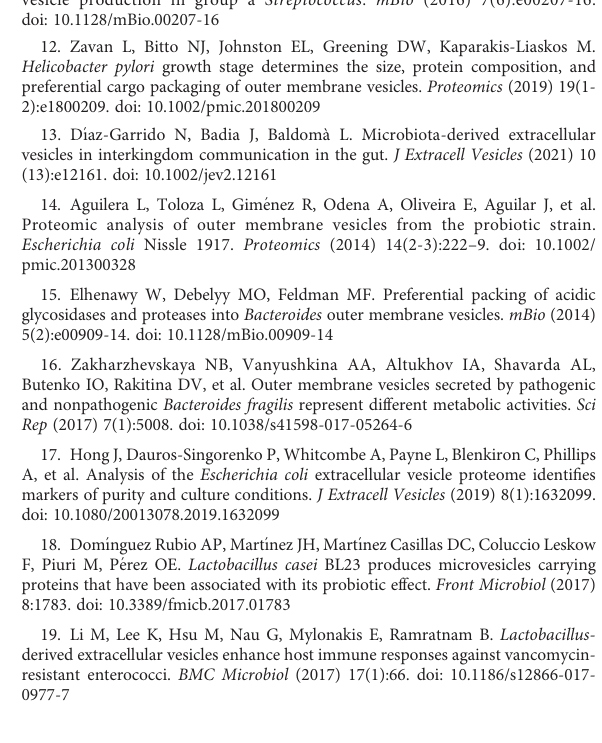
Live and heat-killed B. fragilis bacteria do not activate TLR7, TLR8 or TLR9, and do not decrease the viability of TLR7-expressing cells. HEK-Blue